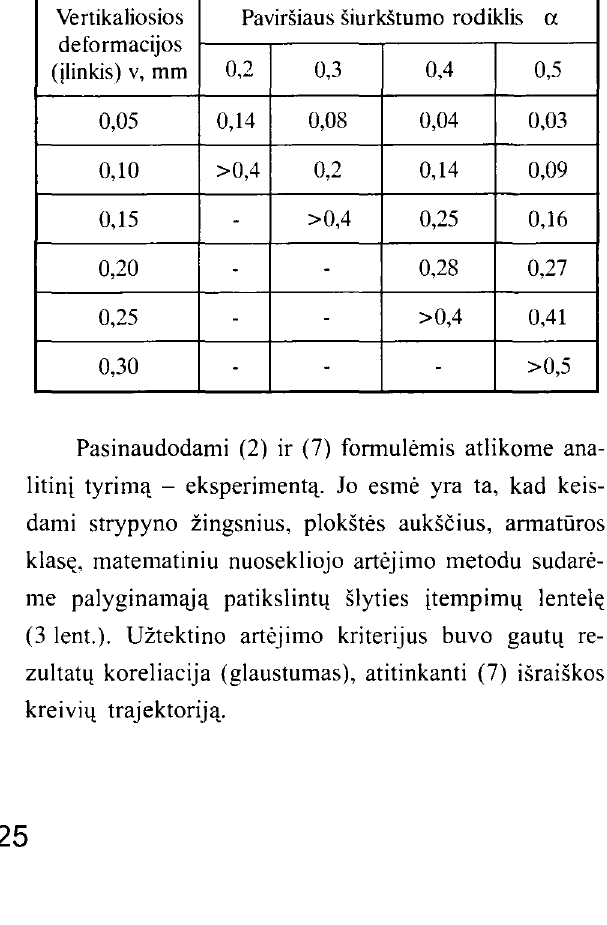
Table 2. Component w (mm) of horizontal strains in section of bending composite element Vertikaliosios